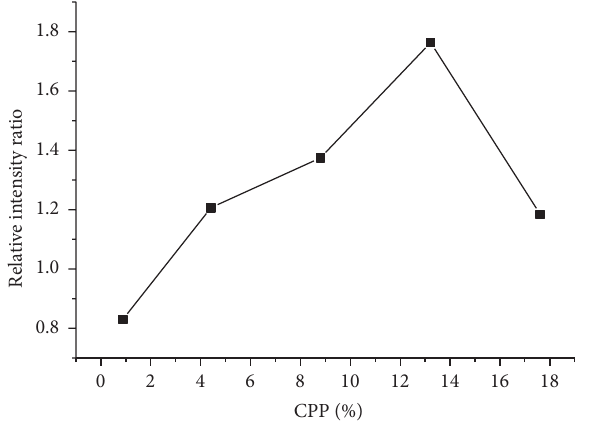
Figure 5: The relation between the ratio of 𝐴 840 /𝐴 810 and CPP content.